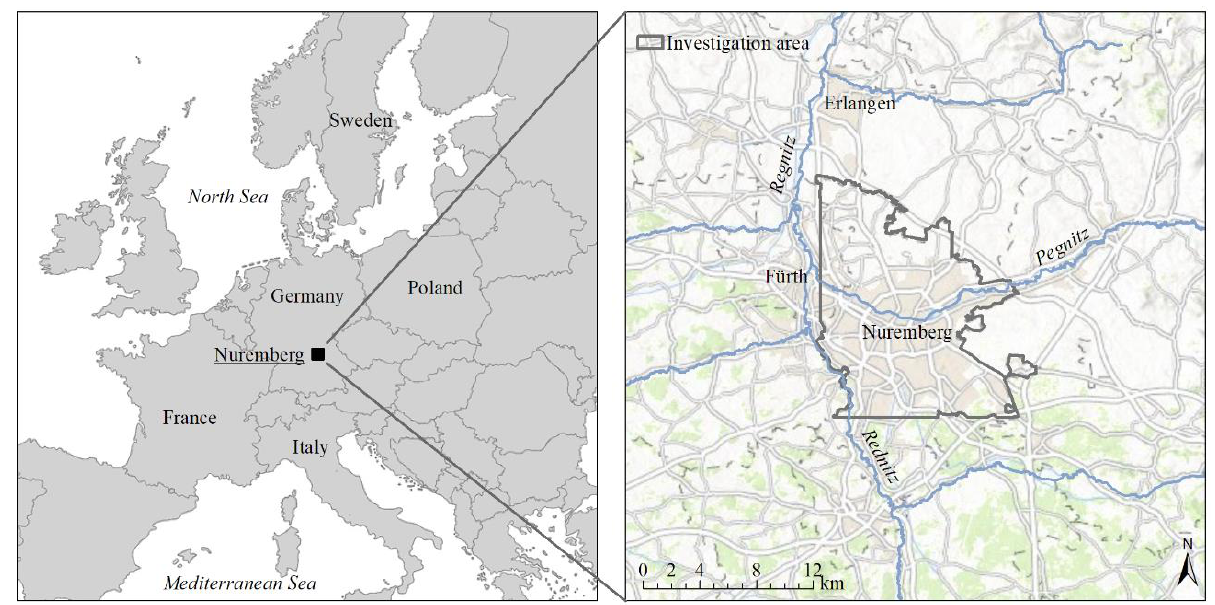
Figure 1. Location of Nuremberg in Europe and Germany. The map on the right hand shows the outline of the investigated area. Sources: Esri, HERE, DeLorme, increment P Corp., NPS, NRCan, Ordnance Survey, © OpenStreetMap contributors, USGS, NGA, NASA, CGIAR, N Robinson, NCEAS, NLS, OS, NMA, Geodatastyrelsen, Rijkswaterstaat, GSA, Geoland, FEMA, Intermap and the GIS user community.